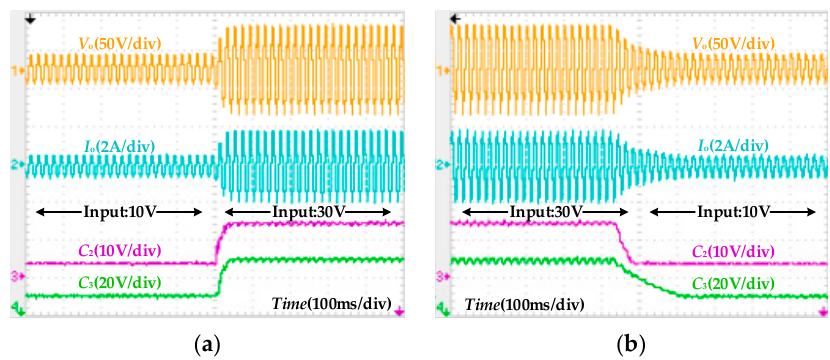
Figure 19. Experiment results when DC source changes. ( a ) Dc source changes from 10 V to 30 V. ( b ) Dc source change from 30 V to 10 V.